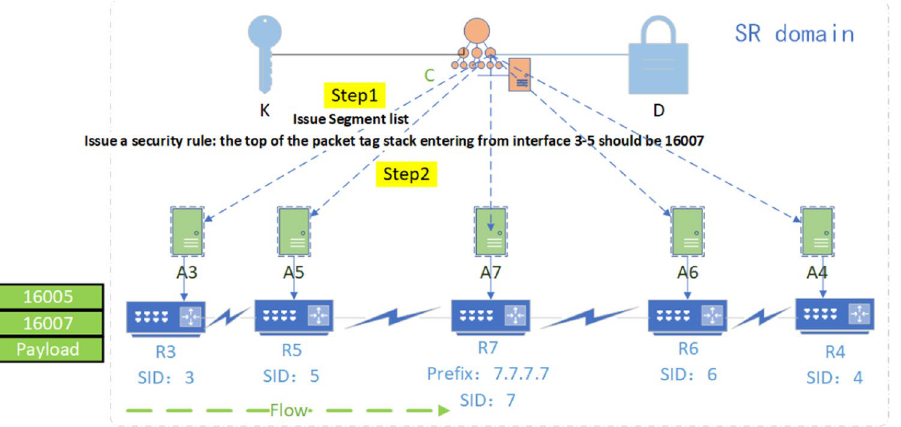
Figure 7. Schematic diagram of SR rule audit.